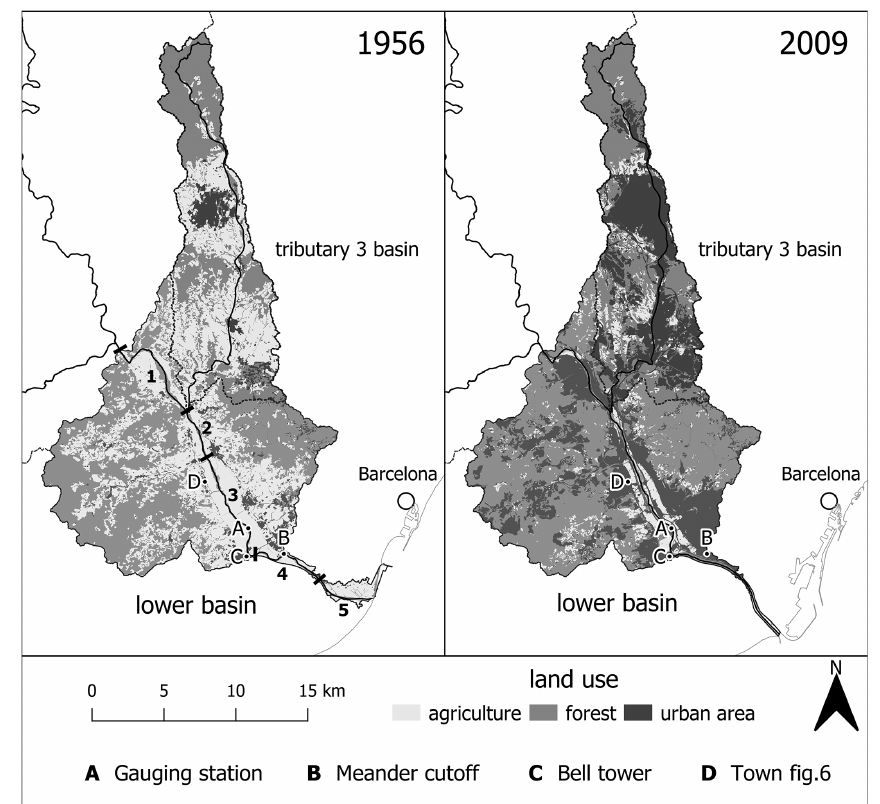
Figure 4. Land use changes in the lower Llobregat basin. Figure produced by authors using our own and freely available data from the CREAF public research center. Note the added information on the lower river (reach nos. 1 to 5 used in the analysis and reference points A to D mentioned in the